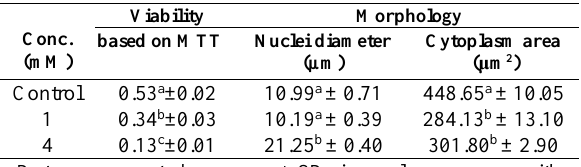
Table 1. Effect of DEA on cell viability (based on MTT) and morphology (based on nuclei diameter and cytoplasm area) of differentiated BMSCs after 21 days of